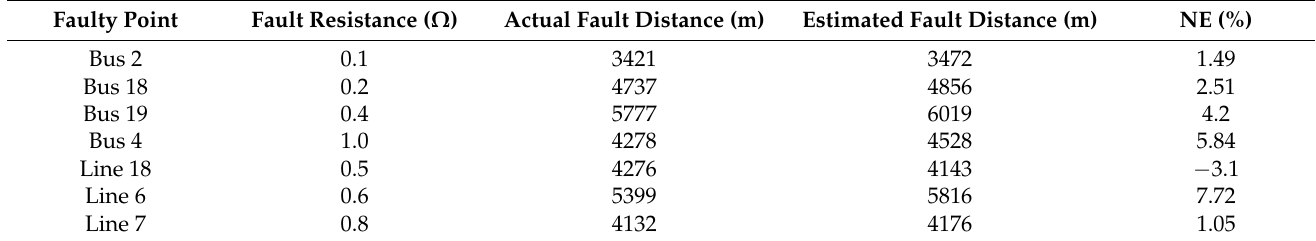
Table 1. Results of estimated fault location for different scenarios.